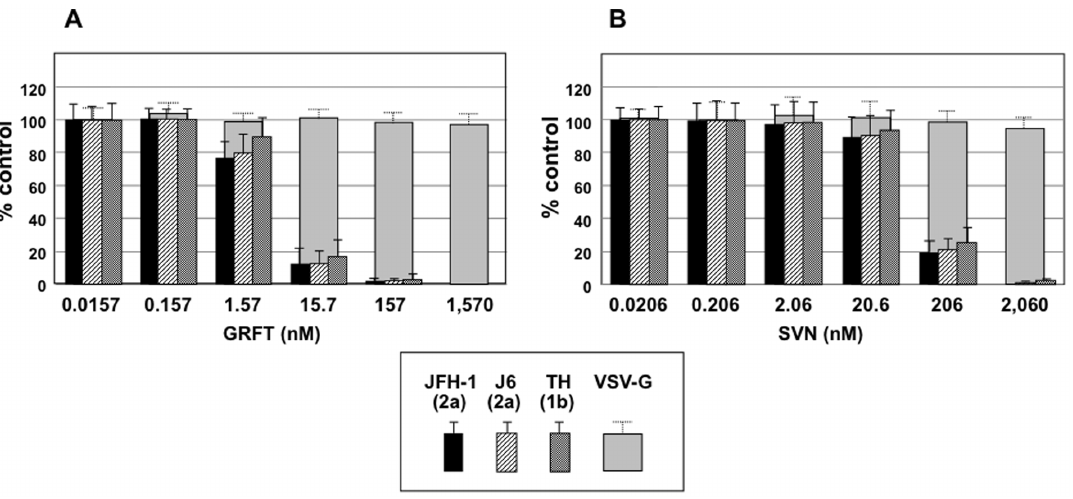
Figure 4. GRFT and SVN inhibit HCVpp entry for different genotypes. Huh7.5.1 cells were incubated for 3 hr with either HCV pseudoparticles(pp) generated with envelope glycoproteins of genotype 2a (JFH-1 and J6 strains) and genotype 1b (TH strain) or VSV-G pp in the presence of increasing amount of GRFT (A) or SVN (B). The inoculum was then removed, and the cells were further incubated. At 2 days post- inoculation, cells were lysed and processed to measure the luciferase activity. The results are presented as percentage of the infectivity relative to infectivity of HCVpp in the absence of carbohydrate binding proteins. Pseudotyped particles produced in the absence of envelope proteins were used as controls, representing , 2% of the activity measured for HCVpp. The results are expressed as the mean 6 SD in triplicate experiments.